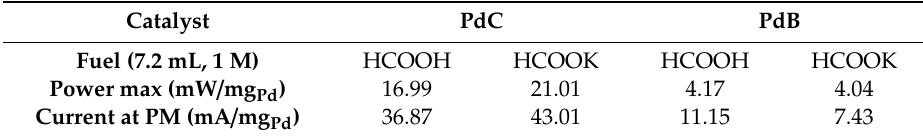
Table 3. Formate / formic acid fuel cells’ maximum power peak data.